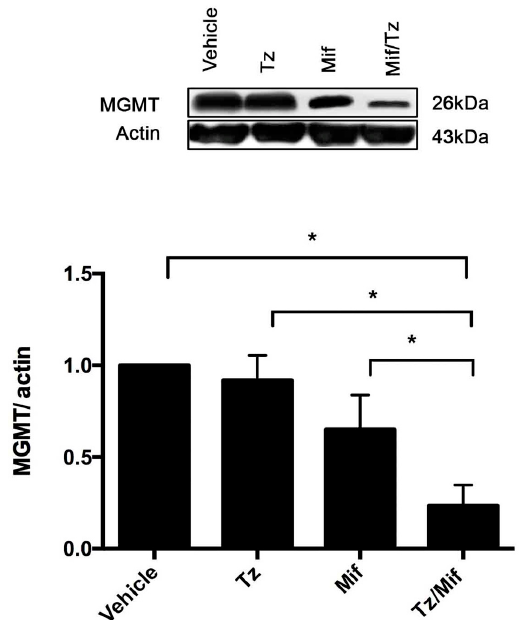
Figure 5. Expression of MGMT (O6-methylguanine-DNA-methyltransferase). Representative western blot results and densitometric analysis of the MGMT protein. Data are expressed as the mean ± SEM of three independent experiments. *A significant difference ( p < 0.05) between Mif/Tz and the other groups with tumor cell implantation (given Tz, Mif or the vehicle).